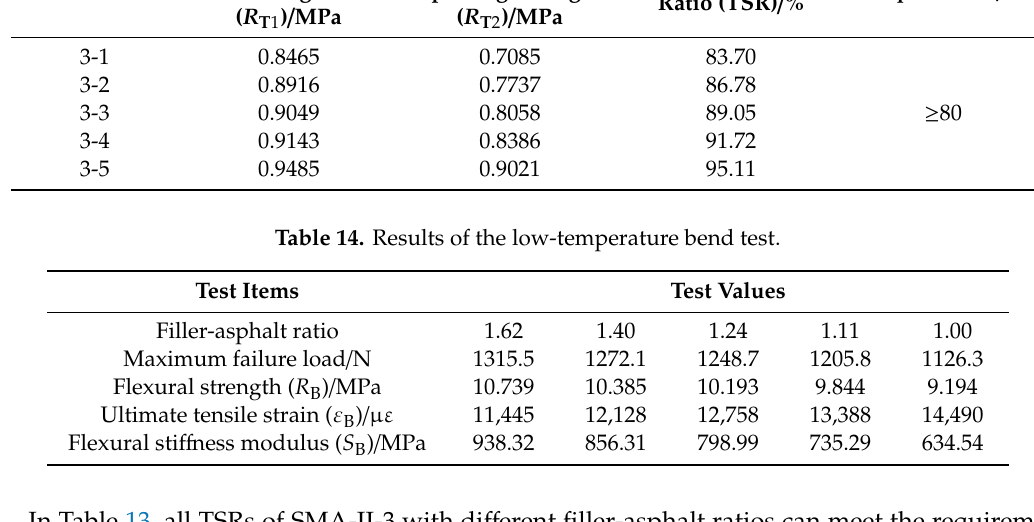
Table 13. Results of the freeze-thaw splitting test.